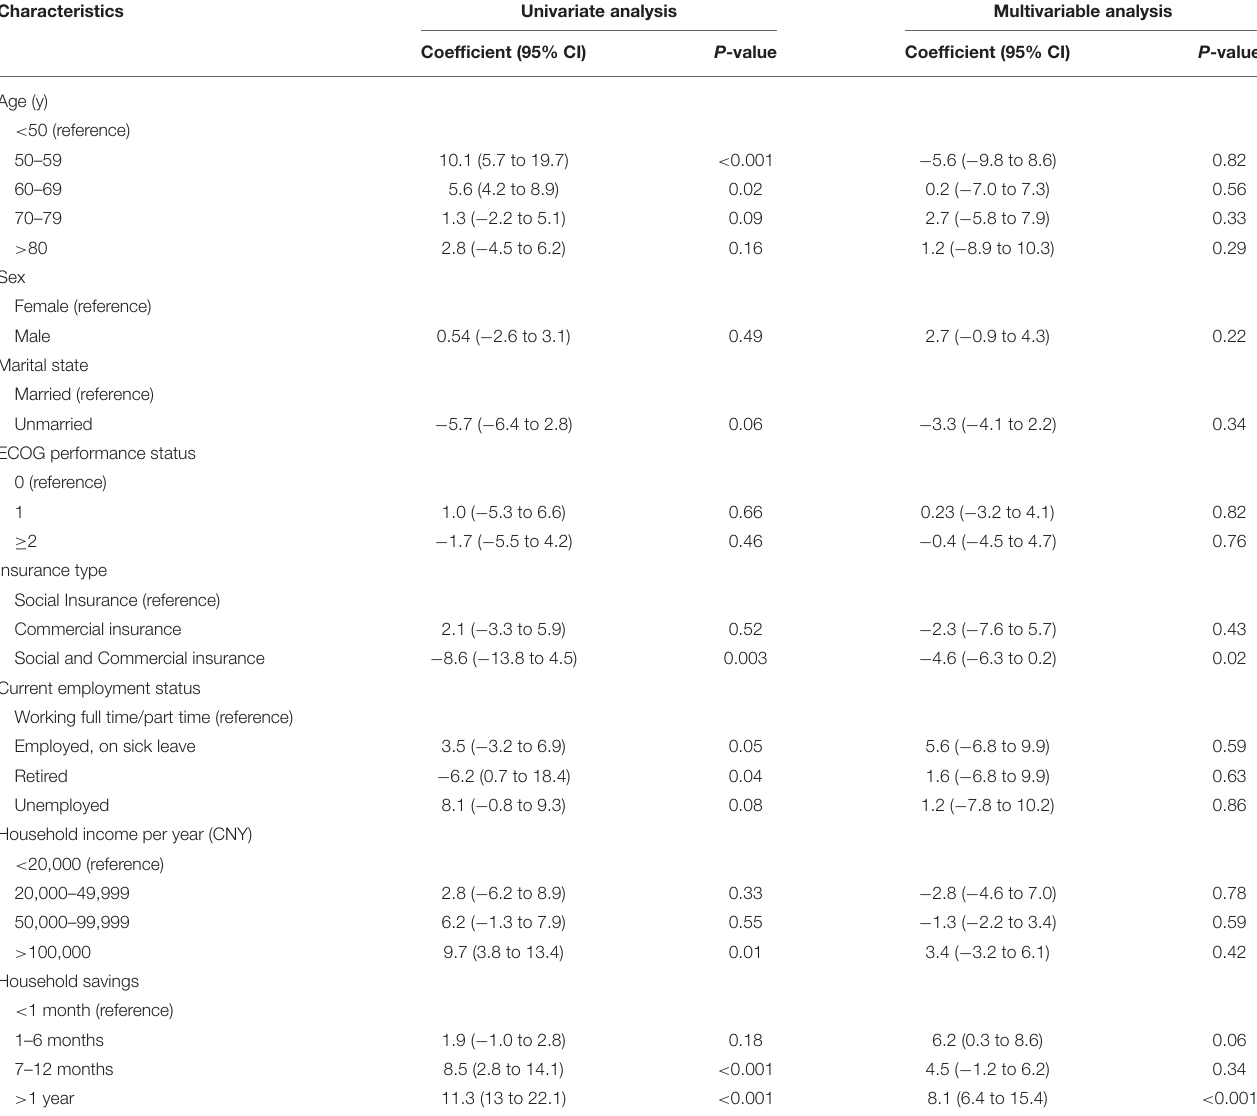
TABLE 2 | Patient characteristics and COST outcomes.